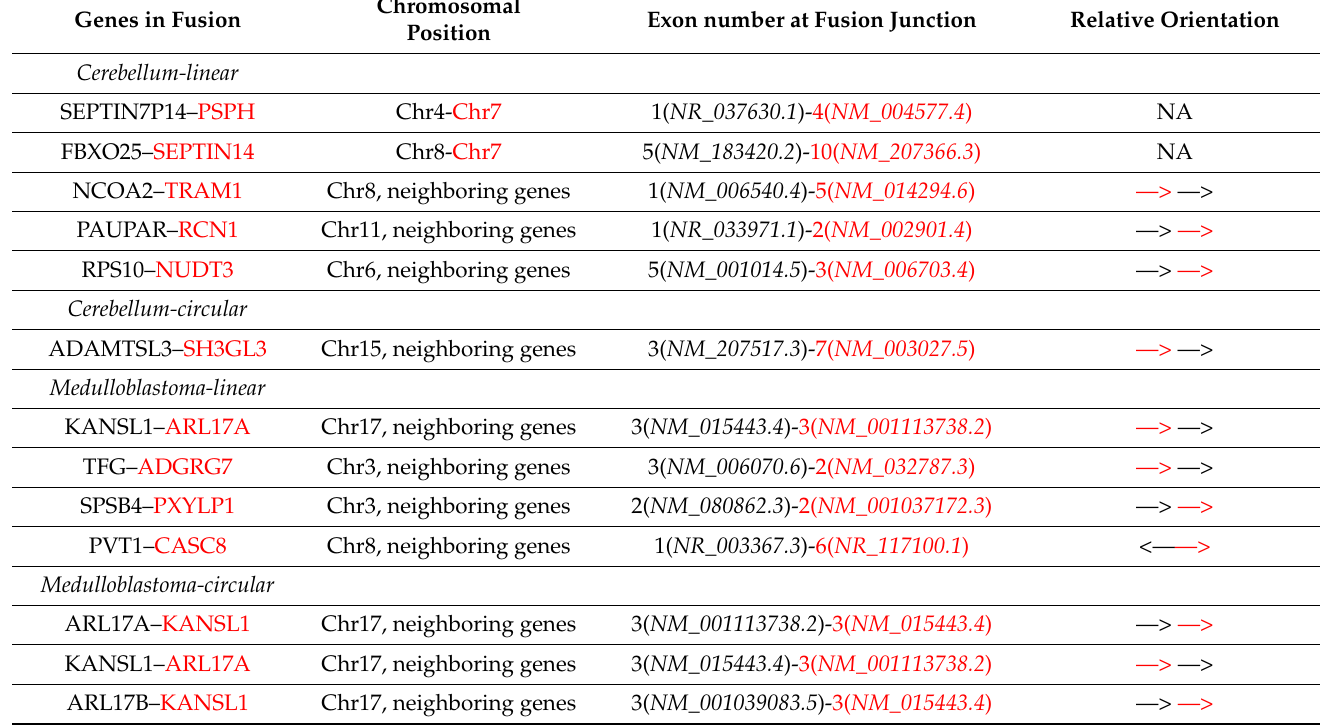
(CB) and medulloblastoma (MB). The y-axis shows the total counts per sample of all fusion transcripts (black rhombi indicate outlier samples). ( B , C ) Violin plots of the expression of the selected fusions (Table 1) in the linear (mdata) and circular (cdata) datasets from cerebellum ( B ) and medulloblastoma ( C ). Note that the selected TFG–ADGRG7 linear fusion in medulloblastoma is also found in the circular dataset. The lack of expression of a selected fusion in a dataset is not shown. Table 1. Selected linear and circular